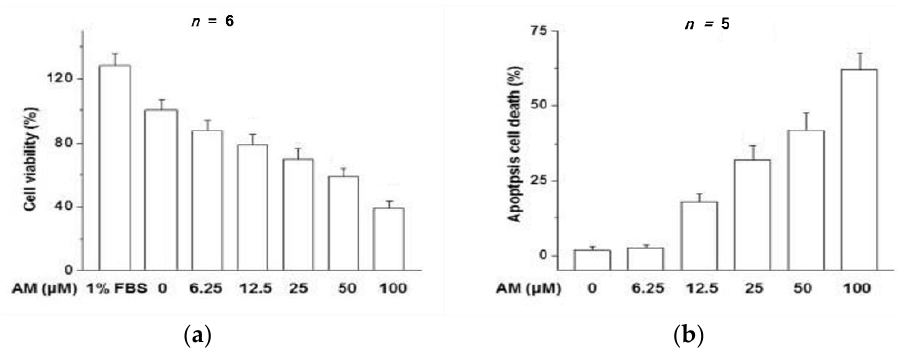
Figure 1. ( a ) The percentage of viable RPE cells decreases from 100% to approximately 40% as amio- darone (AM) concentration increases from 0 μM to 100 μM . ( b ) The percentage of RPE cells under- going apoptosis increases from 0% to approximately 63% as AM concentration increases from 0 μM to 100 μM [37].